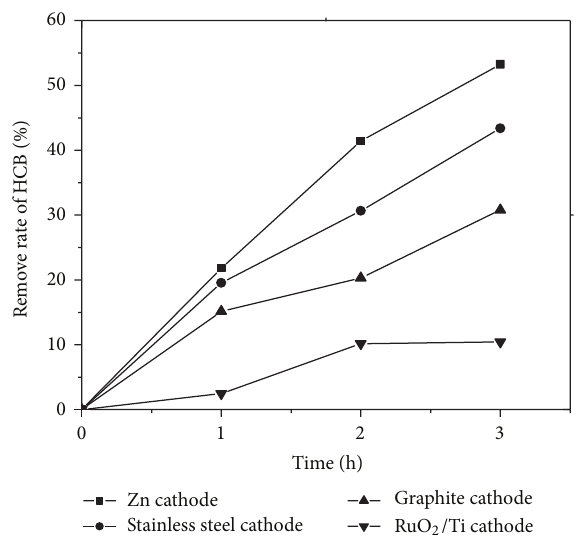
Figure 1: The removal rate of HCB with different cathode materials.